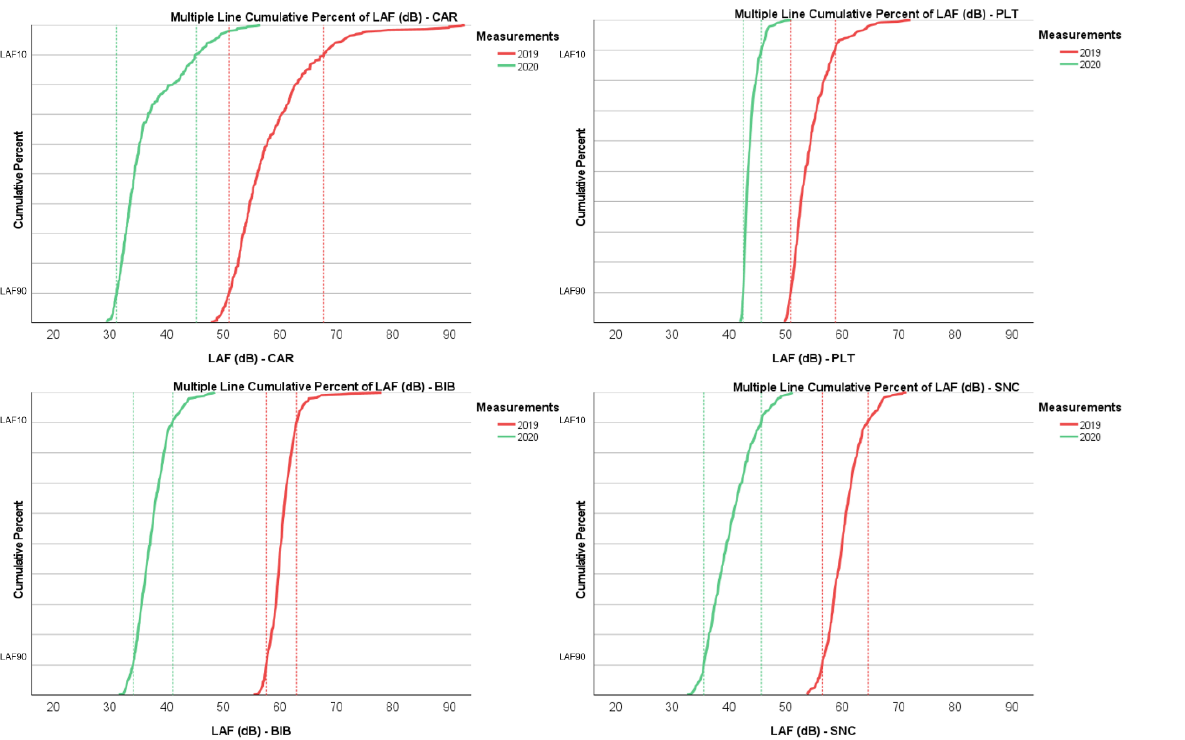
Figure 4: Cumulative distributions of LAF values for the four investigated sites, for the 2019 (red lines) and 2020 (green lines) measure- ments campaigns; for each series, the left dashed line represents LAF90, while the right dashed line represents LAF10